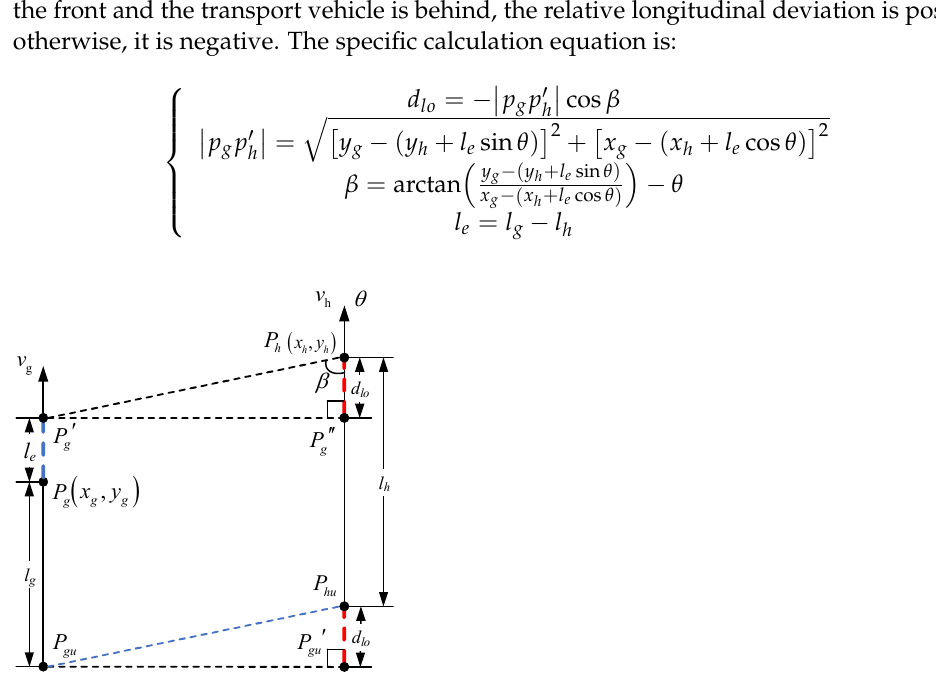
Figure 2. Schematic diagram of a simplified collaborative unloading operation. Note: ( x h ,y h ) is the P h point coordinate, m; ( x g ,y g ) is the P g point coordinate, m; v h is the driving velocity of the harvester, m/s; v g is the driving velocity of the transport vehicle, m/s; θ is the target heading angle of the harvester and transport vehicle; l h is the distance from the projection point of the grain unloading port point, P hu , in the direction of θ with the satellite positioning point of the harvester, P h ; l g is the distance from the target point of grain unloading, P gu , to the satellite positioning point of the transport vehicle, P g ; l e is the difference between l g and l h ; P g ’ is the point at an l e distance from point P g in the direction of θ ; P g ’’ is the projection of point P g ’ in the direction of θ ; P gu ’ is the projection of point P gu in the direction of θ ; β is the angle between P h P g ’ and θ .